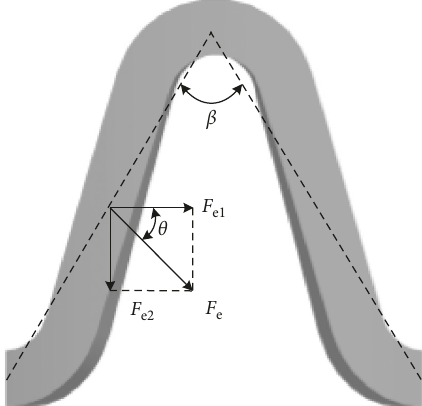
Figure 12: Diagram of supporting element under elastic recoiling